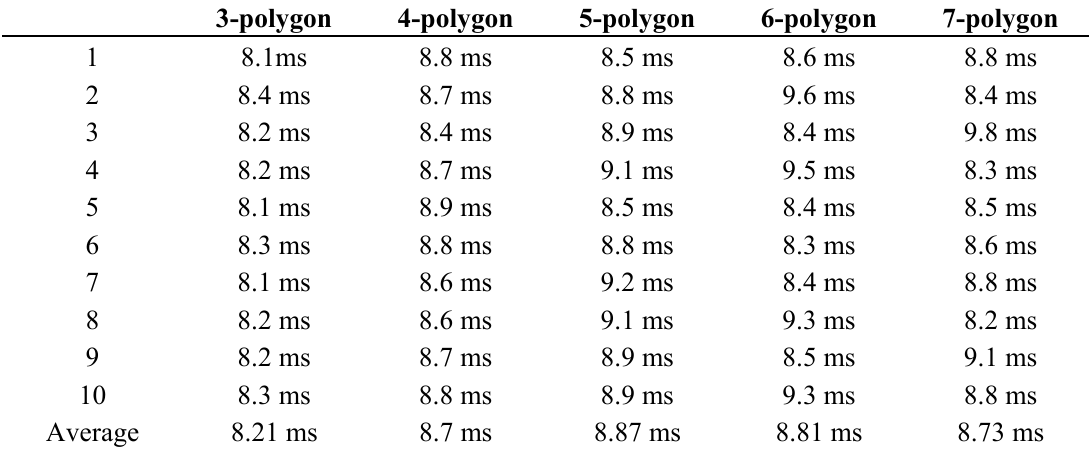
Table 3. The necessary time to calculate a polygonal shape’s center of